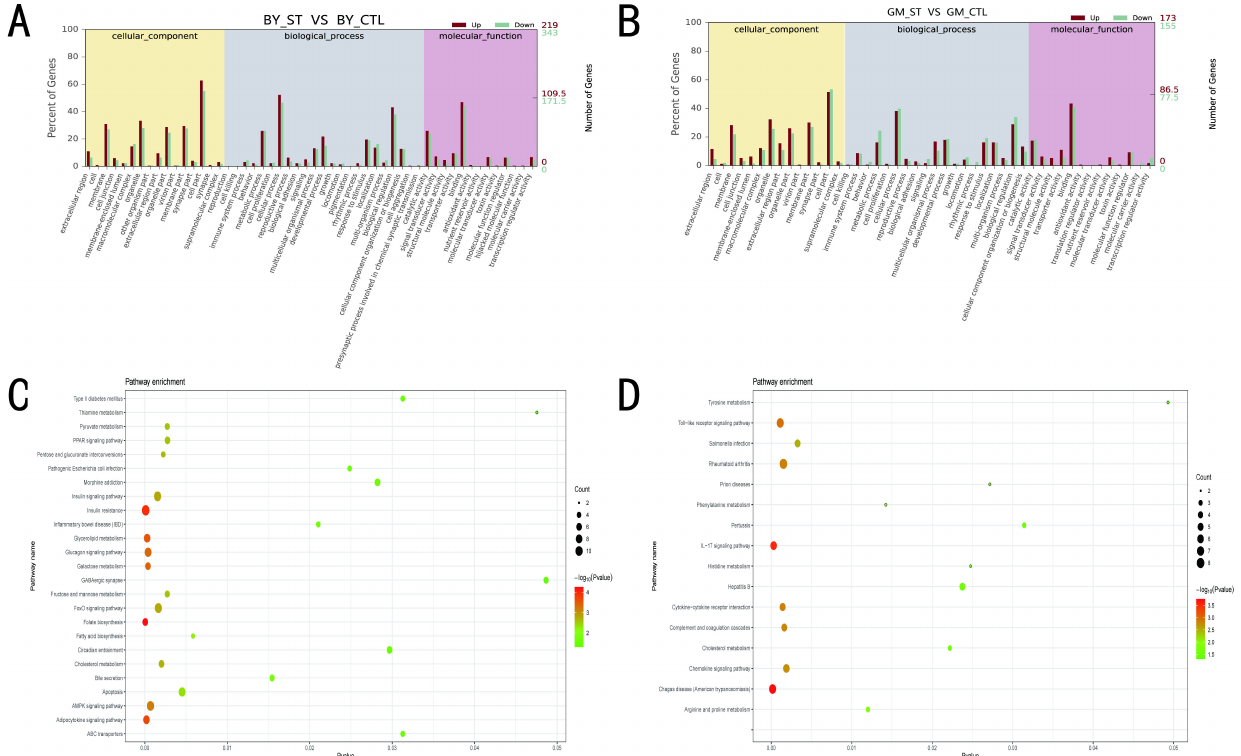
Figure 3. GO terms and KEGG pathways enrichment analysis of BY and GM in response to ST infection. ( A ) GO functional analysis bar chart of BY. ( B ) GO functional analysis bar chart of GM. ( C ) KEGG signaling pathway enrichment analysis of DEGs of BY. ( D ) KEGG signaling pathway enrichment analysis of DEGs of GM. BY_CTL: Beijing You control group, GM_CTL: Guang Ming control group, BY_ST: Beijing You salmonella infection group, GM_ST: Guang Ming salmonella infection